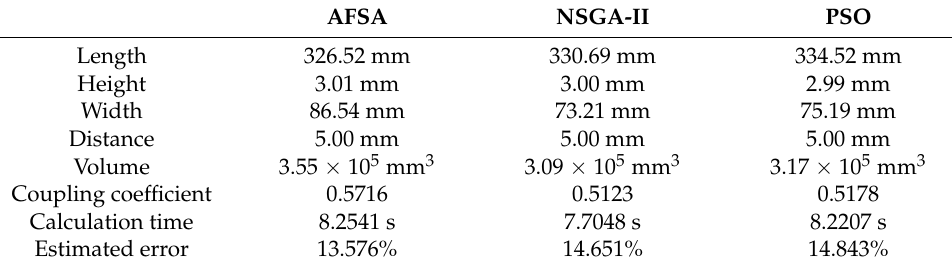
Table 8. Performance comparison for different structure shields.